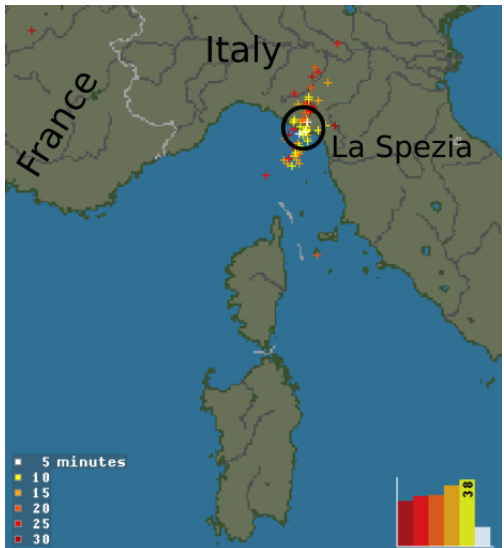
Figure 16. Strikes recorded on 25 October 2011, from 15:25 to 15:55UTC, by means of the Blitzortung network for lightning and thunderstorms, retrieved through the online archive. (courtesy of Blitzortung.org)